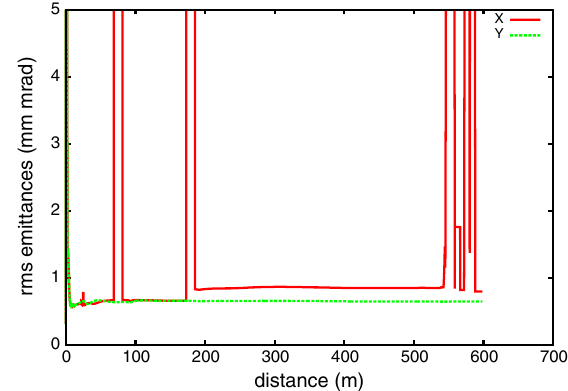
FIG. 10. Evolution of transverse rms emittances (red and green) through the whole accelerator beam delivery system. mrad with a current between 400 and 600 A. The longitudinal phase space still shows small long-wavelength ( ∼ 10 μ m) modulation from the microbunching instability. (The modulation wavelength is consistent with the